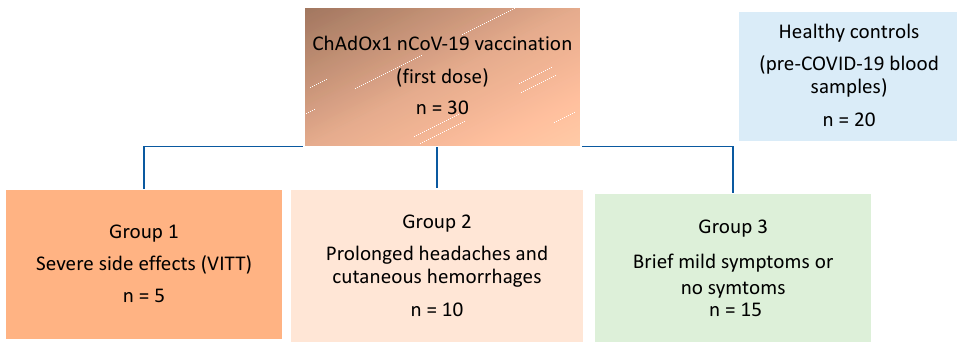
Figure 1. Schematic overview of groups of patients Four groups of participants were included. Group 1-3 had received ChAdOx1 nCoV-19 vaccination (first dose) and experienced complications of different levels of severity. Group 4 consisted of non-vaccinated healthy blood donor controls from pre-COVID era (2015).